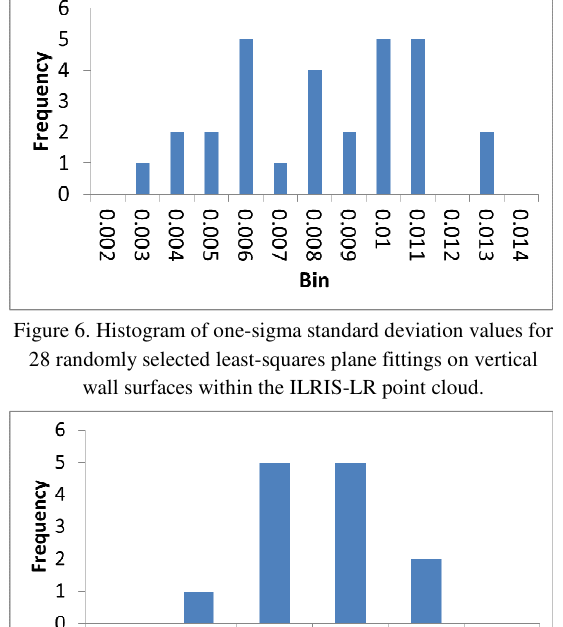
Figure 8. Histogram of one-sigma standard deviation values for 28 randomly selected least-squares plane fittings on vertical wall surfaces within the Geo-X8000 point cloud.